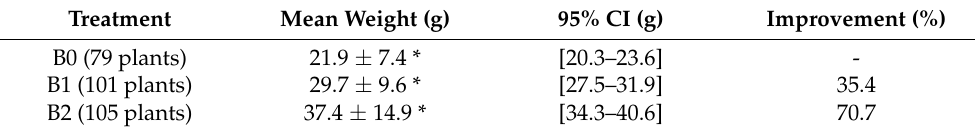
Table 3. Mean radish weight in each treatment, expressed as mean ± standard deviation, with 95% CI standing for the confidence interval at p = 0.05. * Significant difference p < 001.